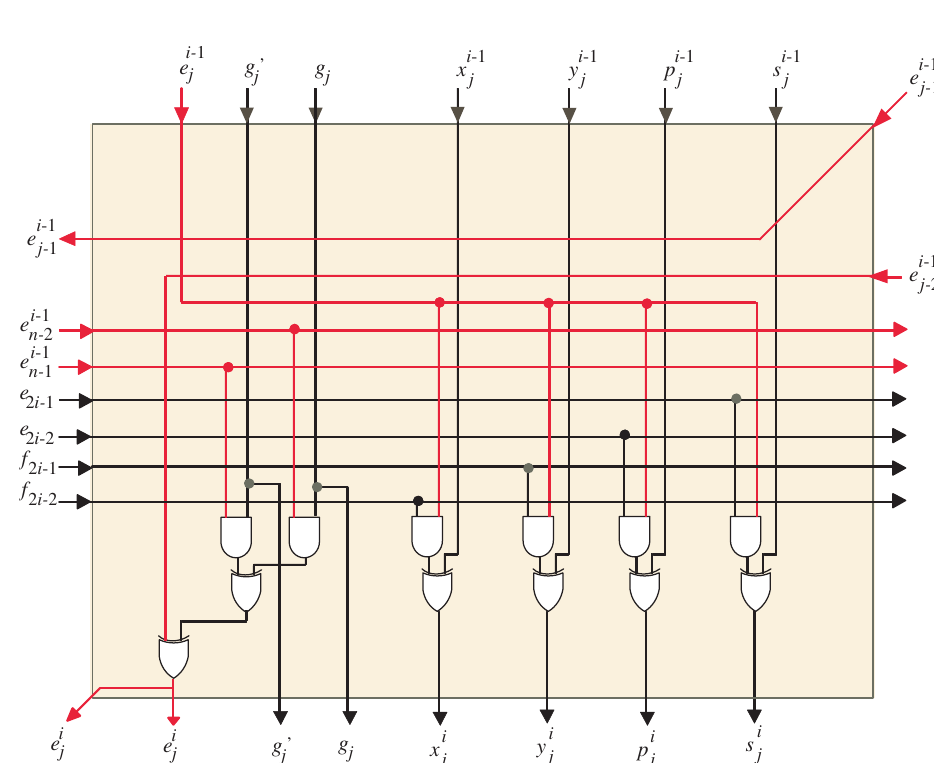
Figure 7. Logic details of the light orange